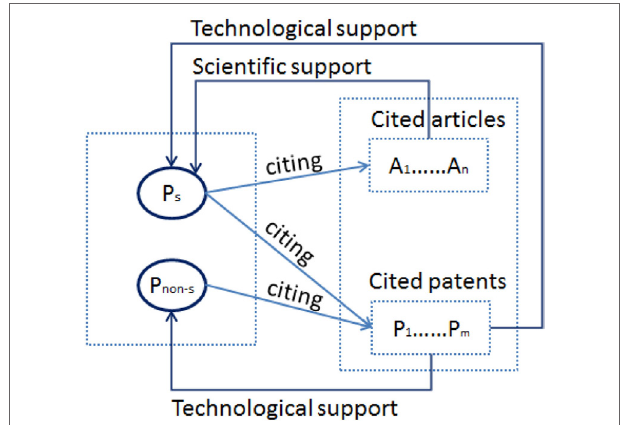
FigUre 1 | Schematic diagram of science­based and non­science­based